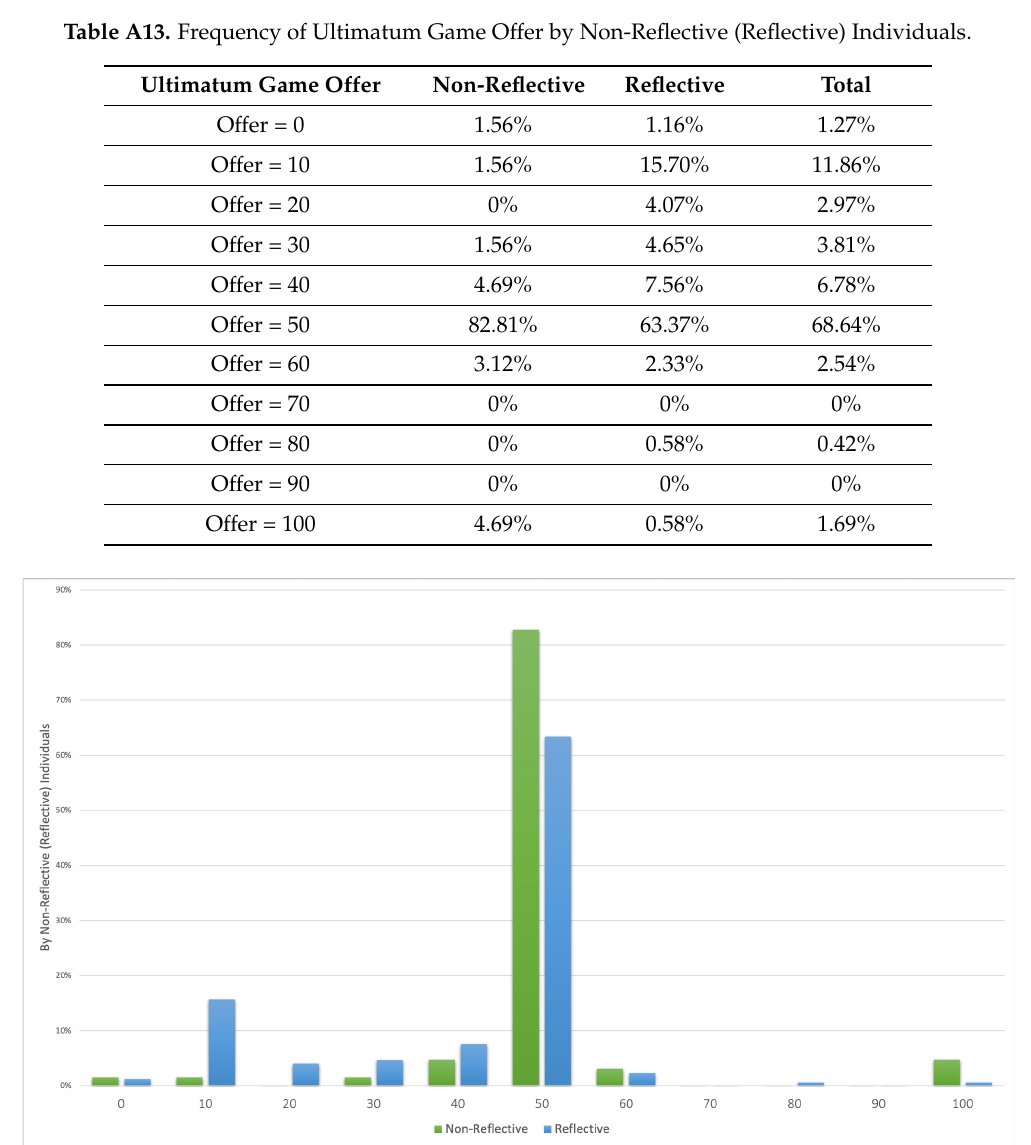
Figure A7. Frequency of Ultimatum Game Offer by Non-Reflective (Reflective)